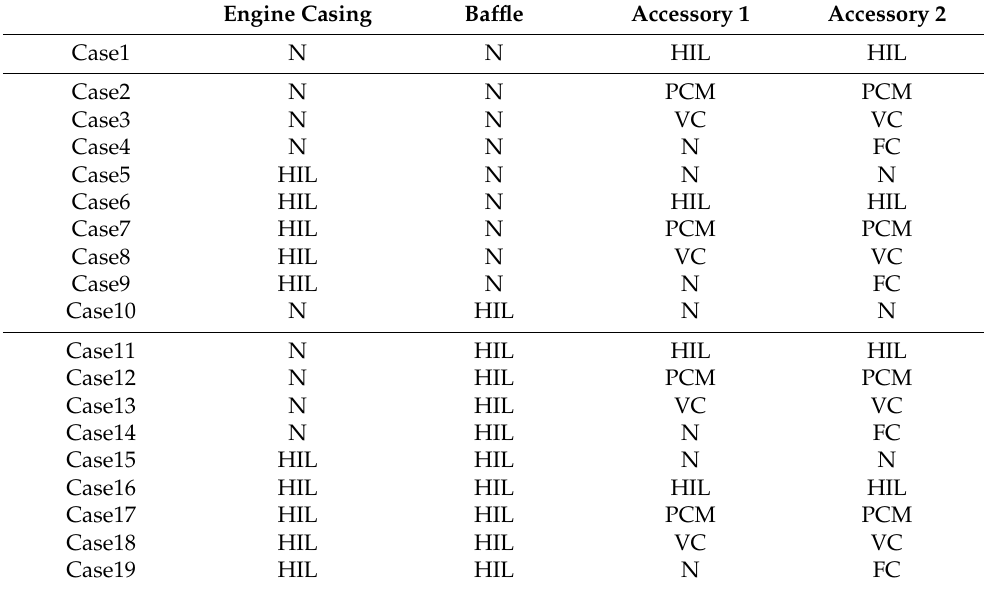
Table 3. Integrated thermal protection cases.